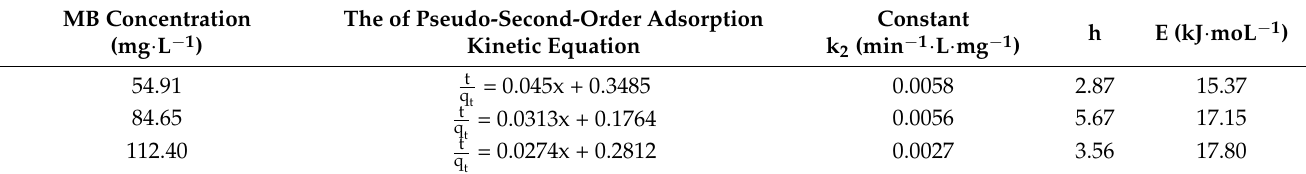
Table 8. Activation energy parameter values.